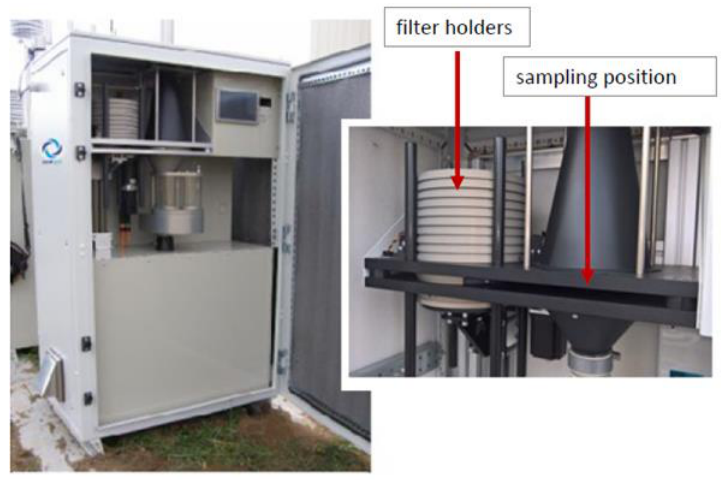
Figure 2. The high-volume sampler SAM Hi 30 AUTO WIND.